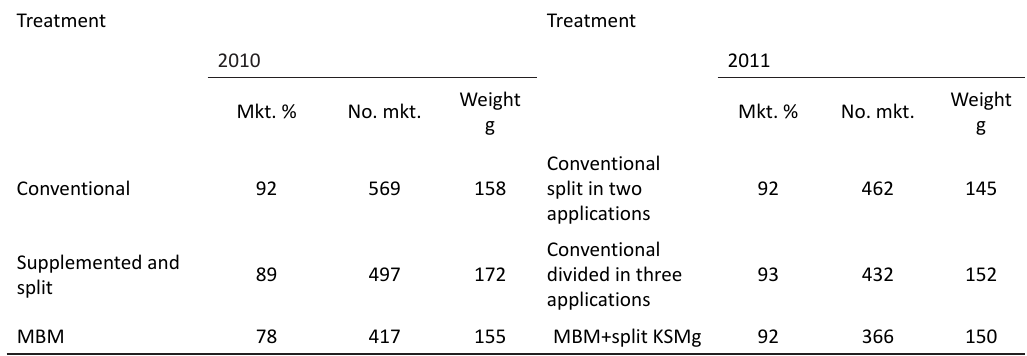
Table 10. Percentage of marketable root yield (t ha -1 ), number of marketable roots (Mkt. no.) and mean marketable root weight of carrot in 2010 and